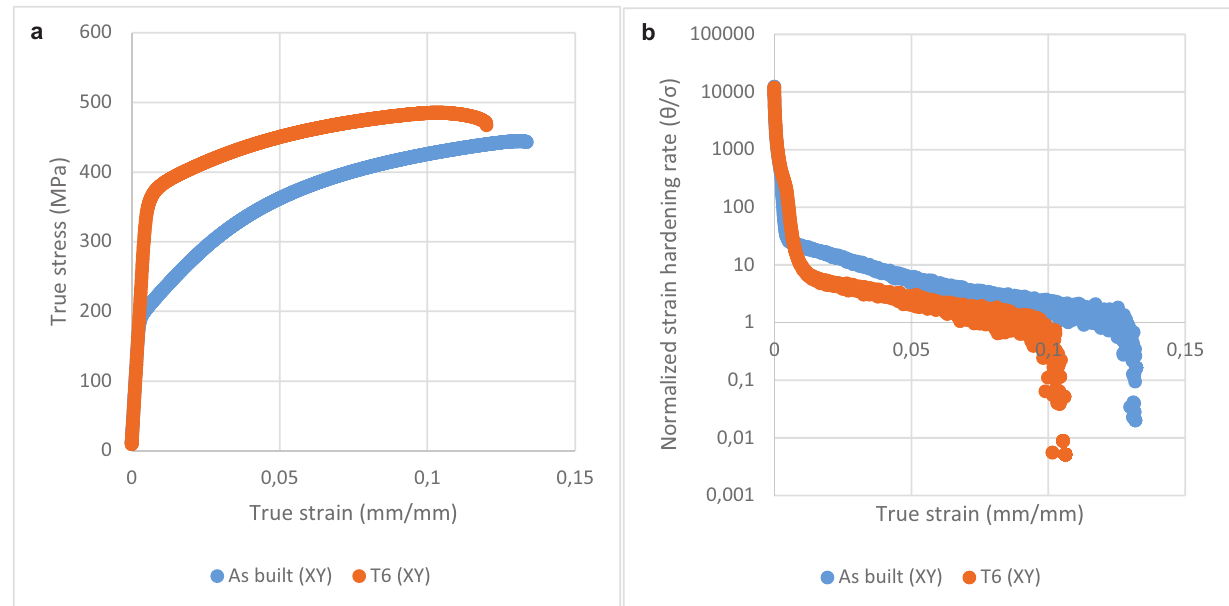
Fig. 13. (a) True stress-strain curves, as-built and T6 tempers (cid:1) (b) Normalised strain hardening rate for the true stress-strain curves of (a).